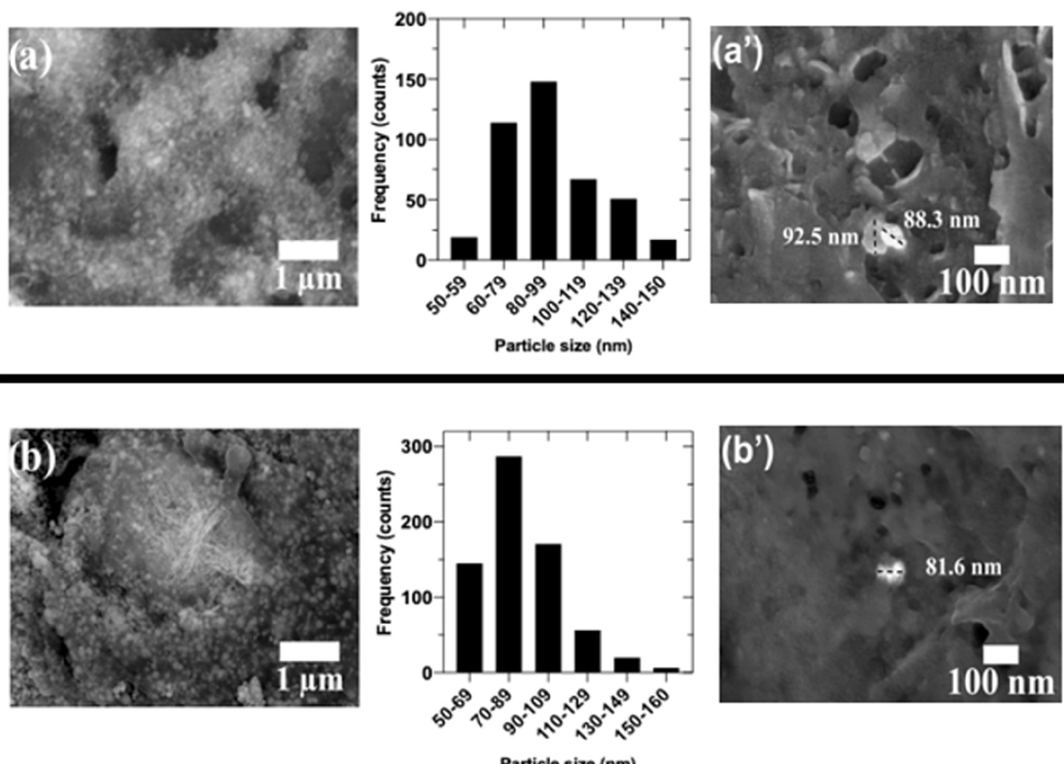
Figure 5. SEM images (20,000 × ), particle size distribution and isolated particle images (100,000 × ) of electroless deposits on Mg-Ca0.3 obtained from: ( a , a’ ) 10 − 3 M ZnO and ( b , b’ ) 10 − 3 M Zn(NO 3 ) 2 solutions.